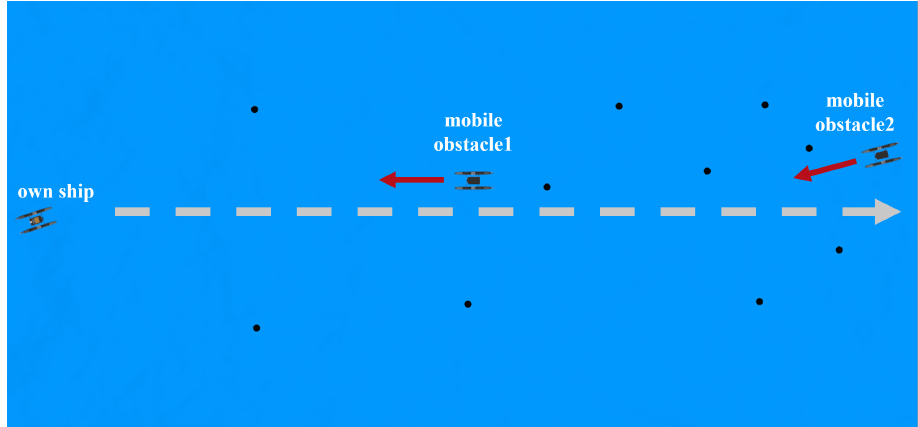
Figure 11. Scenario with fixed and mobile